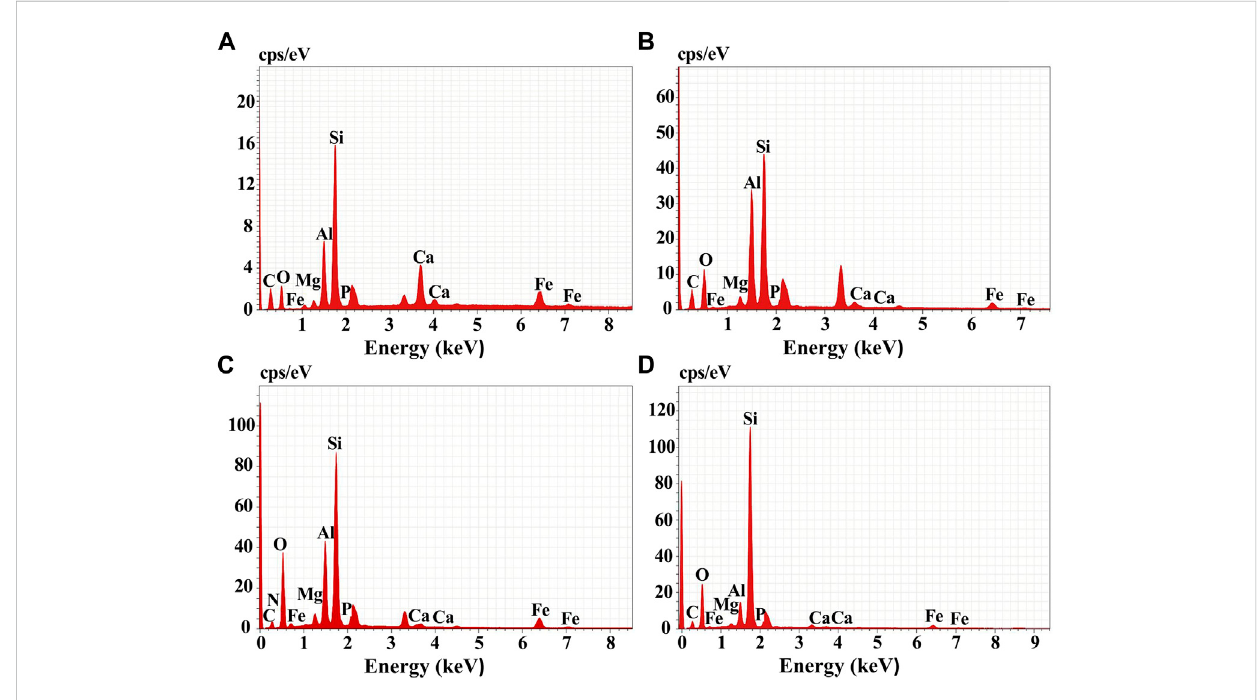
FIGURE 9 SEM-EDS plane scan analysis of the EDS spectrum.